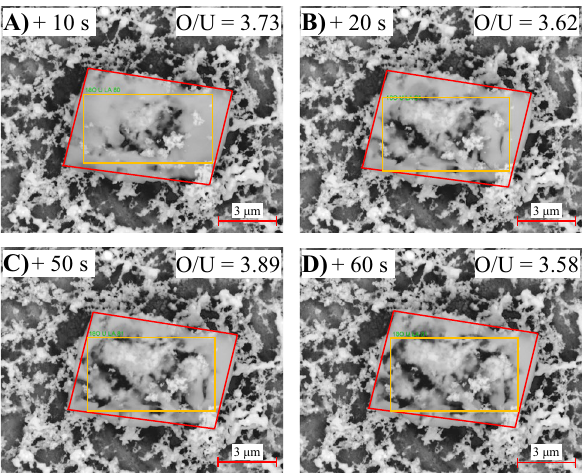
Figure 8. Backscattered SEM/EDS images and O/U ratios of a ~ 8 × 5 μm am-UO x particulate (or collection thereof), where the particulate is outlined in red and the area measured for EDS is outlined in yellow. ( A )–( D ) represent images of the particulate after consecutive EDS spectra were measured with collection times of 10, 10, 30, and 10 s, respectively. As seen, the electron beam affected the sample. The measured O/U ratios were between 3.58 and 3.89, consistent with the am-UO x (3 ≤ x ≤ 4)